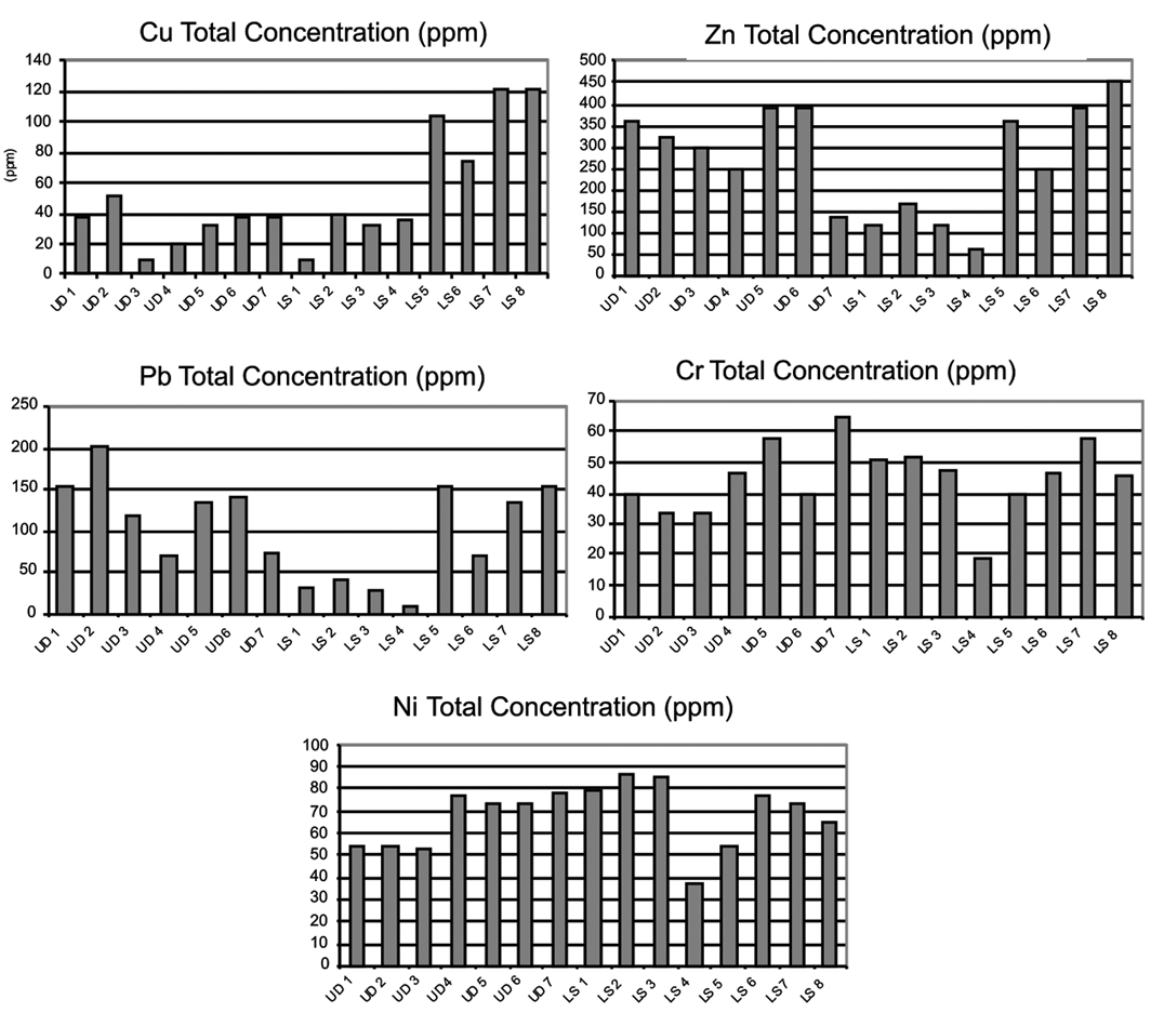
Fig. 3 – Heavy metal total concentration variation during the 2 nd and 3 rd